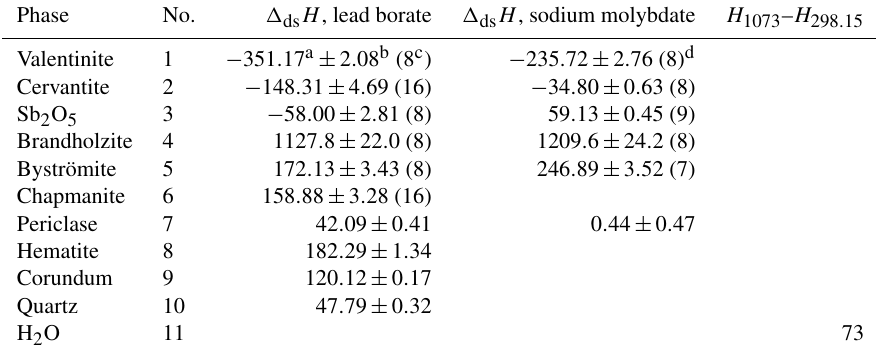
Table 4. Drop solution enthalpies ( (cid:49) ds H ) of antimony compounds and reference phases in lead borate and sodium molybdate melt at 1073K. “No.” is the reaction number of the reactions in Table 3. Data for the drop-solution enthalpies of reference Sb-free phases from Navrotsky (2014), with the exception of MgO (Lilova et al., 2019). H 1073 – H 298 . 15 is heat content between T = 298 . 15 and T = 1073K. Heat content is calculated from heat-capacity polynomials in Robie and Hemingway (1995). All data are in kJmol − 1 . Phase No. (cid:49) ds H , lead borate (cid:49) ds H , sodium